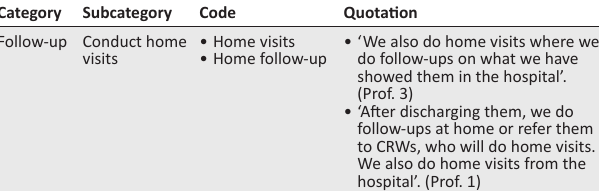
TABLE 6: Role of rehabilitation professionals: Follow-up. Category